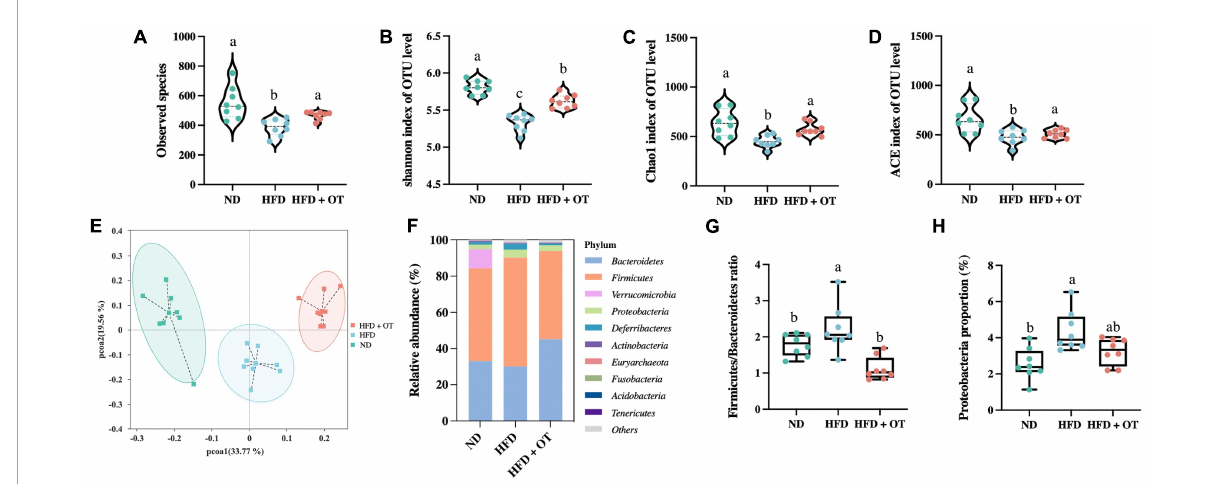
FIGURE5 Oolong tea reshaped the gut microbiota components in HFD-fed mice. (A) Observed species. (B) Shannon index. (C) Chao1 index. (D) ACE index. (E) Weighted UniFrac PCoA. (F) Relative abundance of gut microbiota at the phylum level. (G) Firmicutes/Bacteroidetes ratio. (H) Relative abundance of Proteobacteria. Data are expressed as mean ± SEM ( n = 8, randomly selected within the group). The mean value with different letters indicates significant differences ( p <